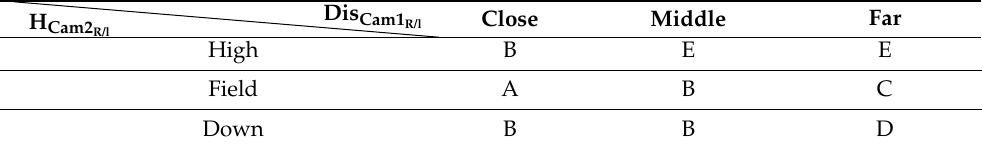
Table 3. Rule list—First-level fuzzy logic